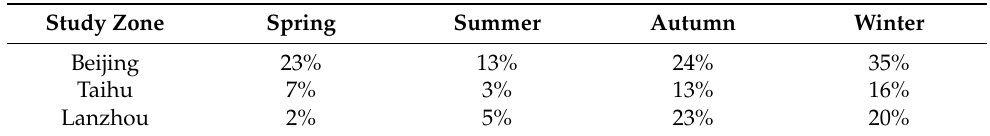
Table 3. Proportion of BrC in EBC in different